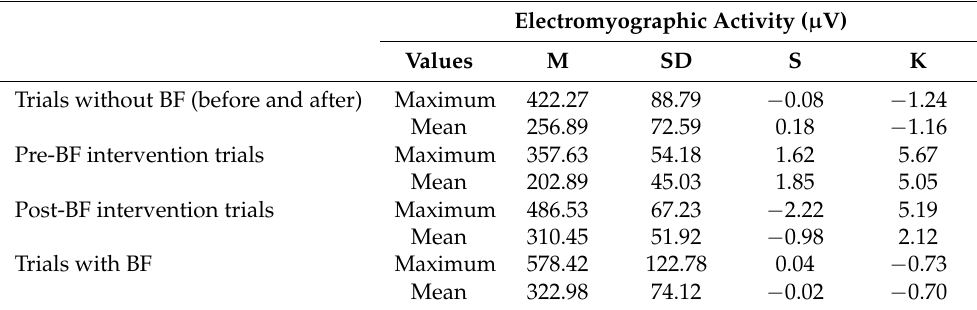
Table 3. Descriptive statistics for maximum and mean electromyographic activity values for the trials with and without biofeedback, as well as before and after